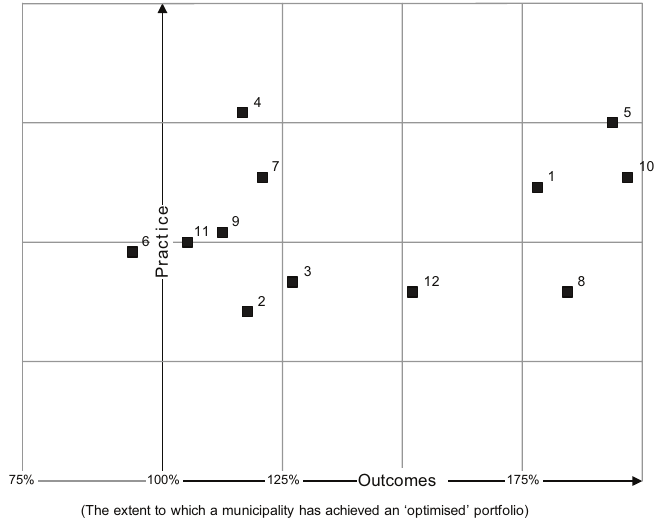
figure 4. relationship between rationale and practice / practice and